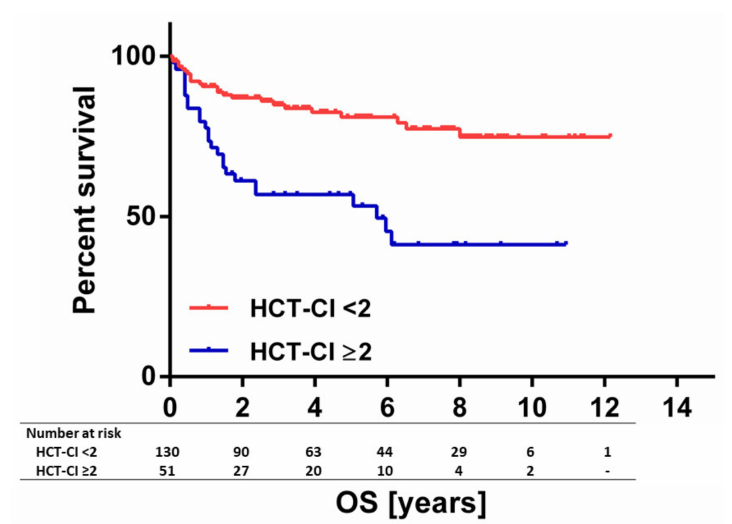
Figure 2. Overall survival according to HCT-CI. 3-year and 5-year OS was 84.9% and 81.0% in patients with an HCT-CI of 0–1. 3-year and 5-year OS was 56.8% and 56.8% in patients with an HCT-CI of ≥